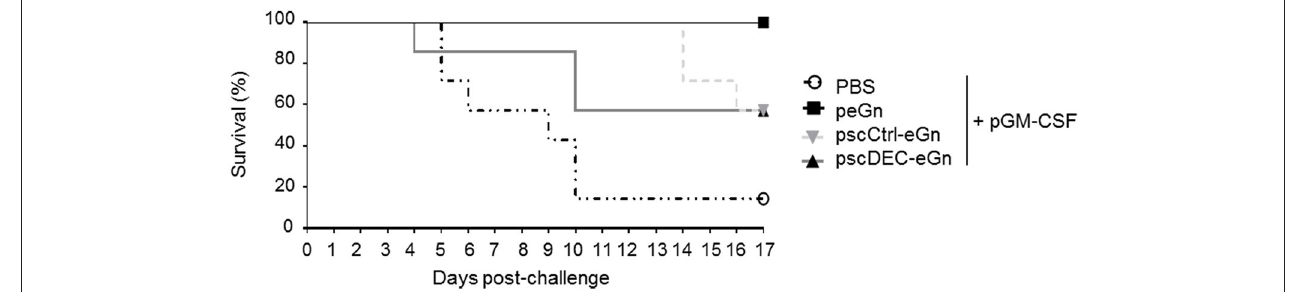
FIGURE 5 | Protection induces by peGn, pscCtrl-eGn, and pscDEC-eGn against RVFV infection. Six to eight-week-old female Balb/c were immunized twice at day 0 and 21 with 100 µ g of peGn, pscCtrl-eGn, pscDEC-eGn, or saline buffer (PBS) with 20 µ g of pGM-CSF as an adjuvant. The plasmids were intradermally injected in the flank and immediately followed by surface electroporation (1,730 V/cm). Three weeks after the last immunization, mice were challenged with 10 3 pfu of RVFV (strain ZH501). The survival was daily monitored for 17 days and the percentage of survival is shown ( n = 7 per